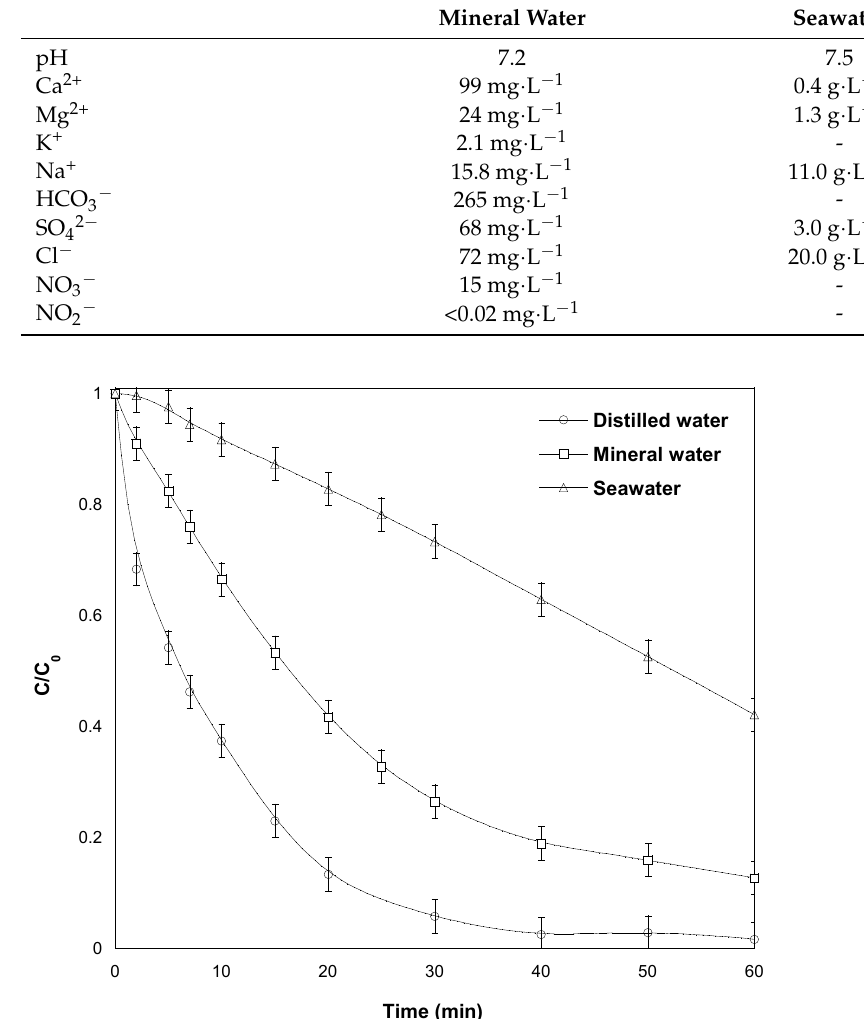
Figure 11. Removal of SO from real water matrices by UV/TiO 2 /IO 3 − process ([IO 3 − ] = 0.15 mM, [TiO 2 ] = 0.4 g · L − 1 and [SO] = 10 mg · L − 1 ).